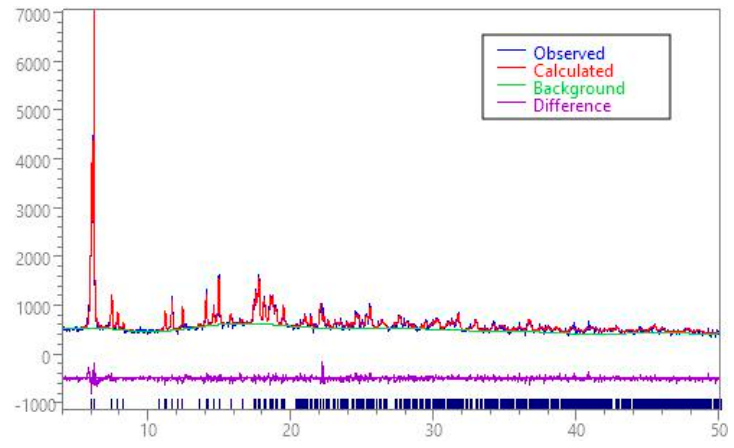
Figure 6. Rietveld plot of 3 [Eu(OOCC 6 H 5 ) 3 ·(HOOCC 6 H 5 ) 2 ]. (blue line) Observed diffraction profile; (red line) calculated profile; (green line) background and (violet line) difference profile.